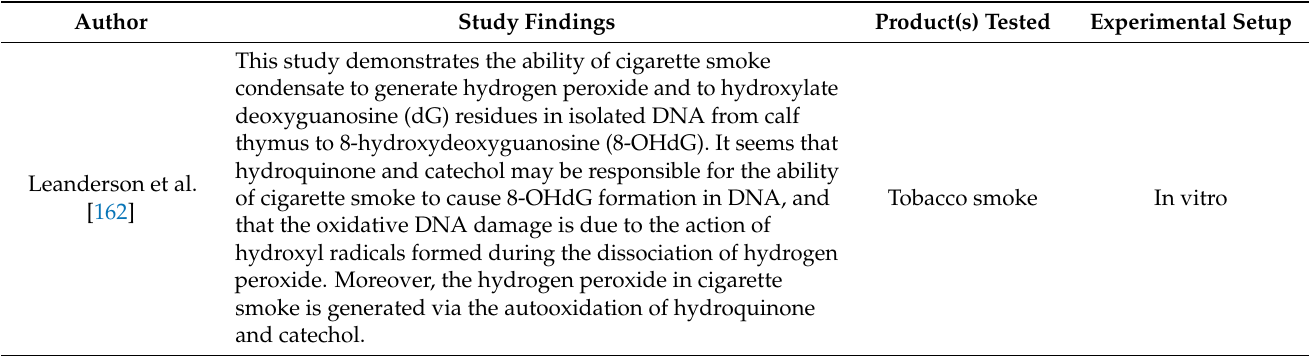
Table 3. Relevant research on oxidative stress related to tobacco smoke and NGP aerosols in